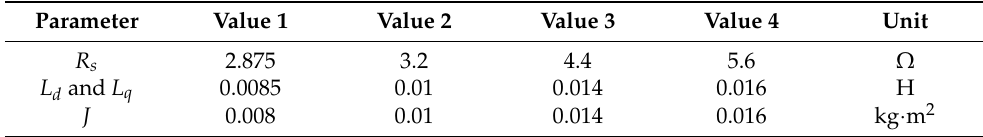
Table 3. PMSM variation parameters—variable structure 2.